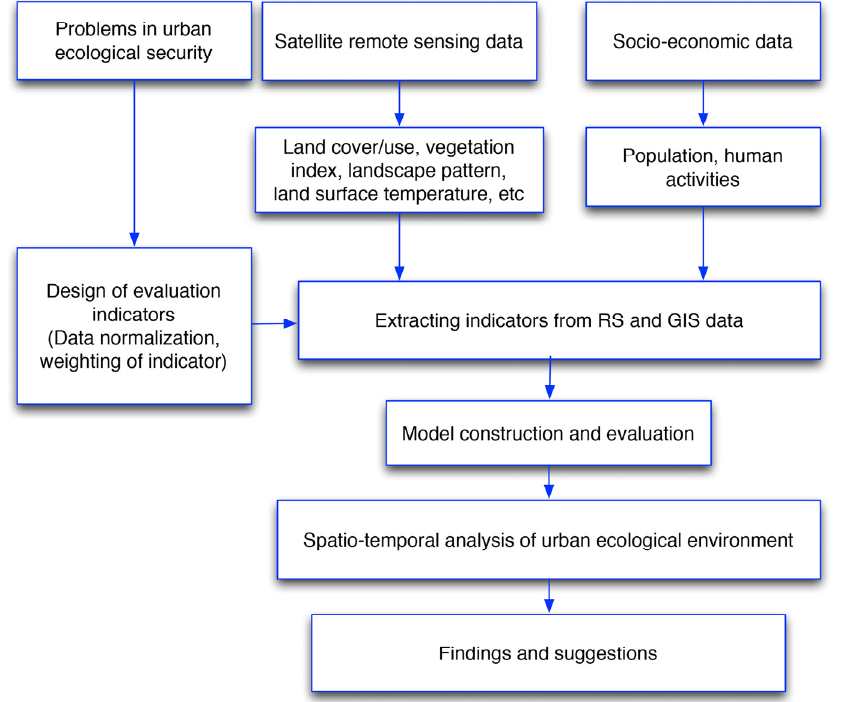
Figure 7. Technical Flow of the ecological security